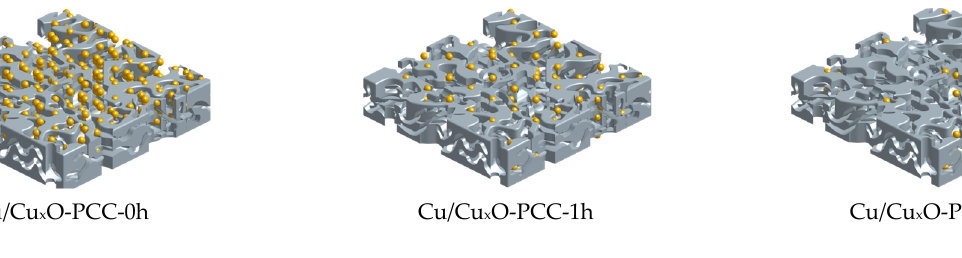
Figure 9. Schematic representation of the three